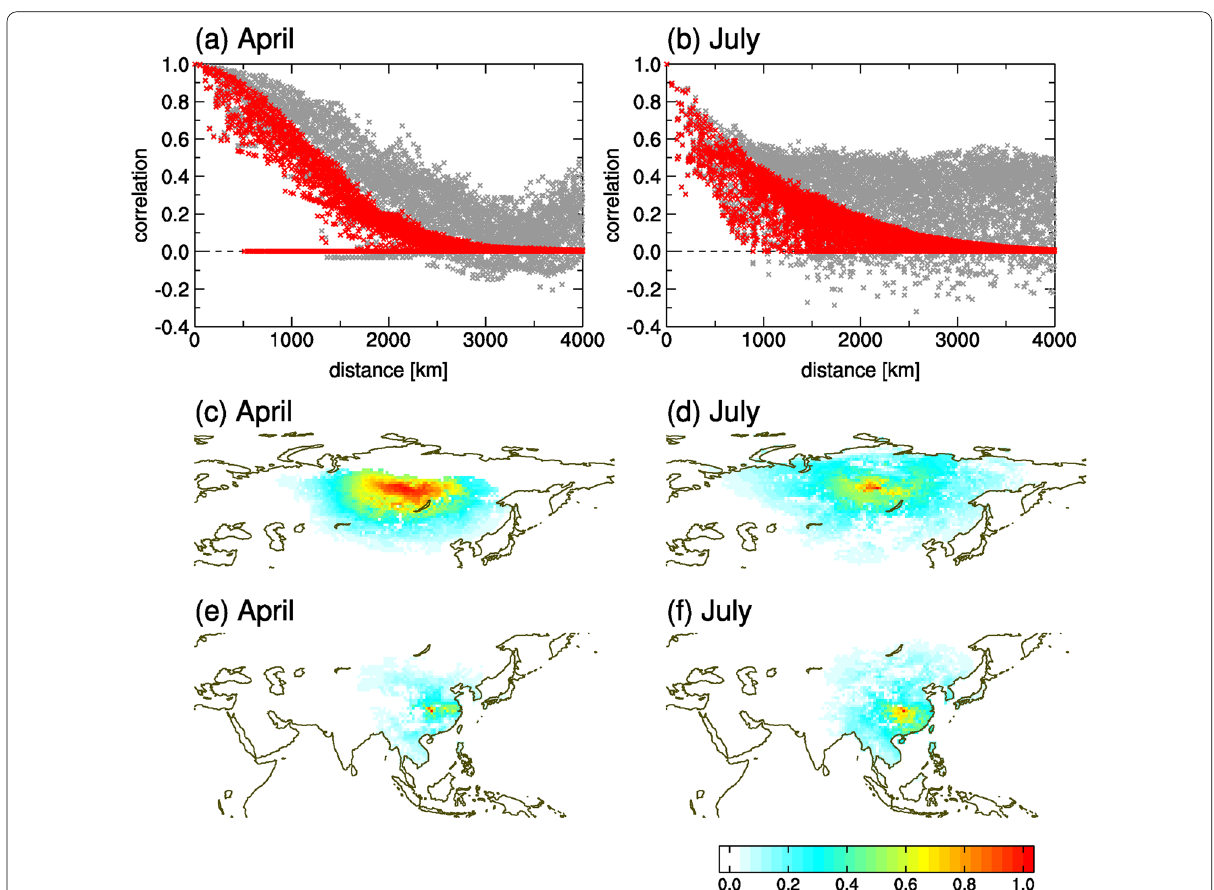
Fig. 2 Error correlations of a prior gross primary production (GPP) flux at near 60.5° N, 100.5° E along with distance for April ( a ) and July ( b ). Gray and red crosses represent correlations before and after localization (Eq. 8), respectively. Spatial structures of the localized error correlations of a and b are shown in c and d , respectively. Furthermore, e and f are the same as c and d but for a different prior GPP flux at near 30.5° N, 110.5°